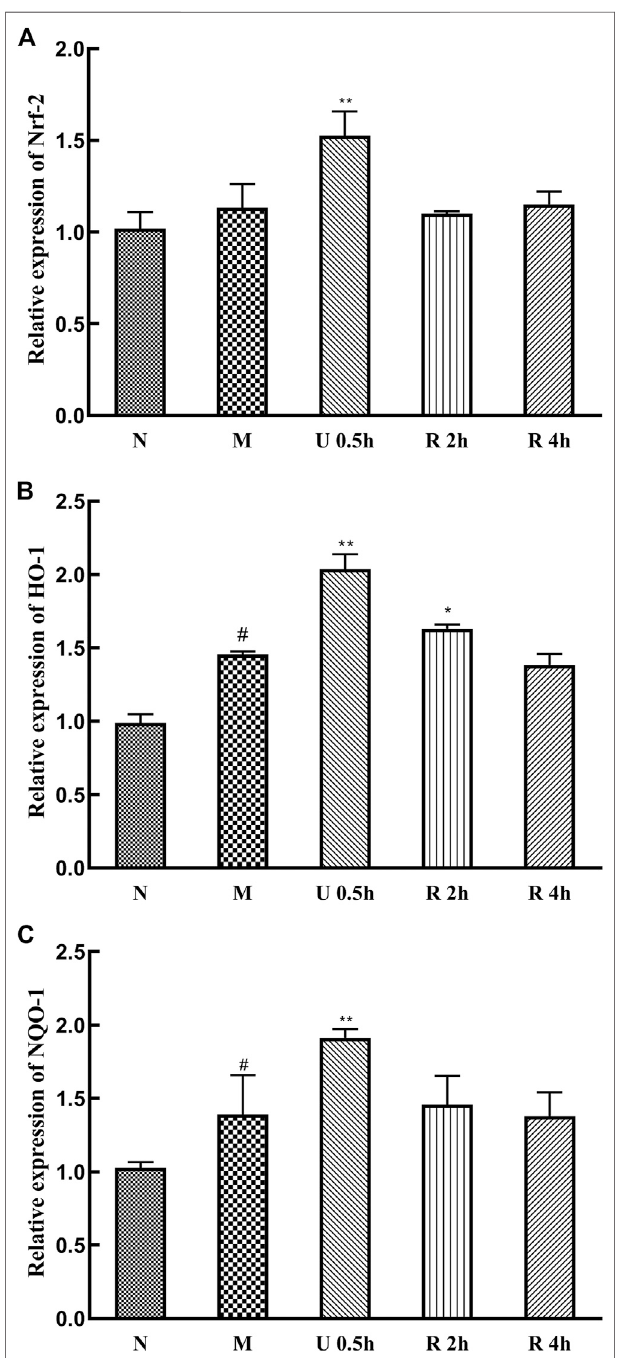
FIGURE 7 | Relative expression of Nrf-2 (A) , HO-1 (B) and NQO-1 (C) mRNA( x ± s, n (cid:1) 6).ComparedwithgroupN, # p < 0.05, ## p < 0.01;compared with group M, * p < 0.05, ** p <